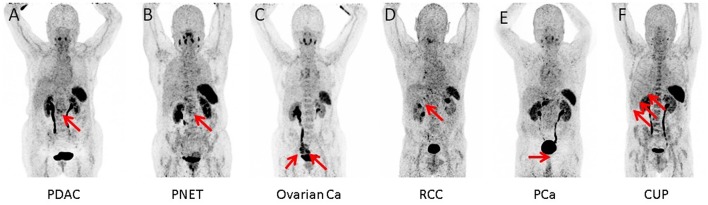
Maximum intensity projections of CXCR4-directed positron emission tomography of other selected tumor entities, primarily demonstrating moderate to no uptake on CXCR4-directed imaging (arrows). Pancreatic ductal adenocarcinoma [PDCA; (A)], pancreatic neuroendocrine tumor [PNET; (B)], ovarian cancer (C), renal cell carcinoma [RCC; (D)], prostate cancer [PCA; (E)], and cancer of unknown primary (CUP) with multiple liver metastases (F). Only the tumor masses of the patient with low-grade ovarian carcinoma (patient #9) display relevant CXCR4 expression.